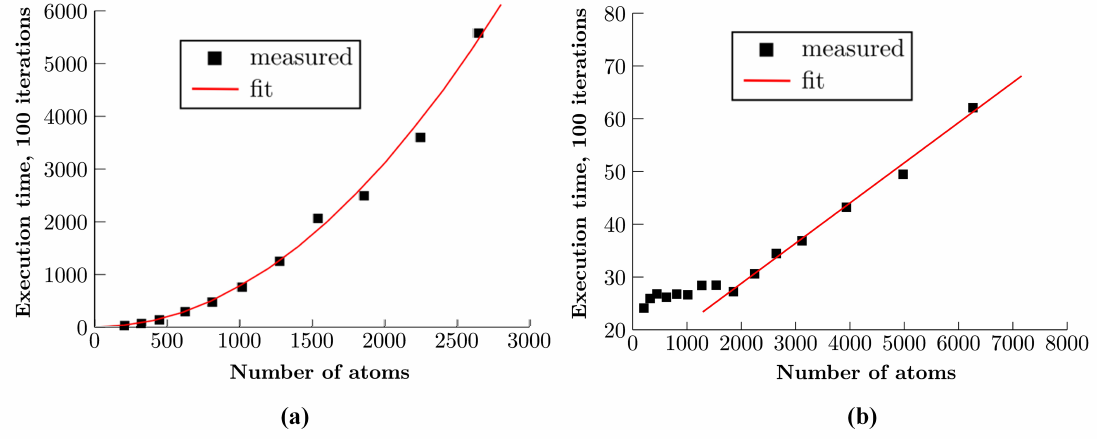
Figure 4. Total execution time, in milliseconds, for 100 iterations of atom relaxation with only gold interaction and motion enabled. ( a ) The graph shows the performance of the old CPU simulation, while ( b ) shows the calculation speed of our GPU simulation. In addition to the notable difference between the two implementations, we see that the time it takes the GPU to execute 100 iterations is nearly constant for a small number (less than 2000) of atoms, while a linear relation is observed in the cases with a higher number of